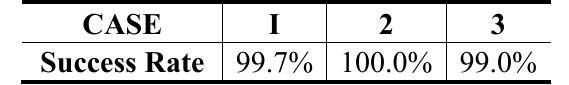
Table 1 . Success rate of the ambiguity resolutions (epoch-by-epoch).